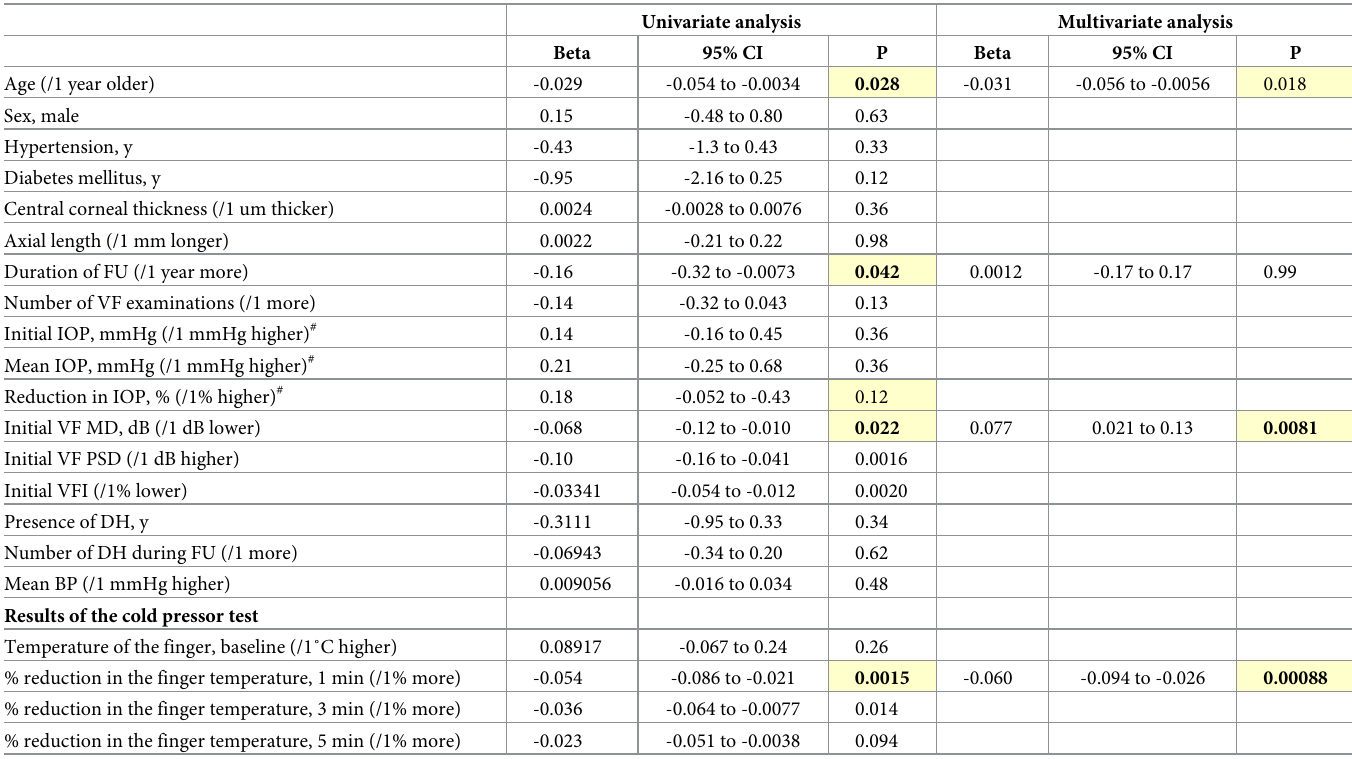
Table 5. Factors associated with faster VF progression rates.